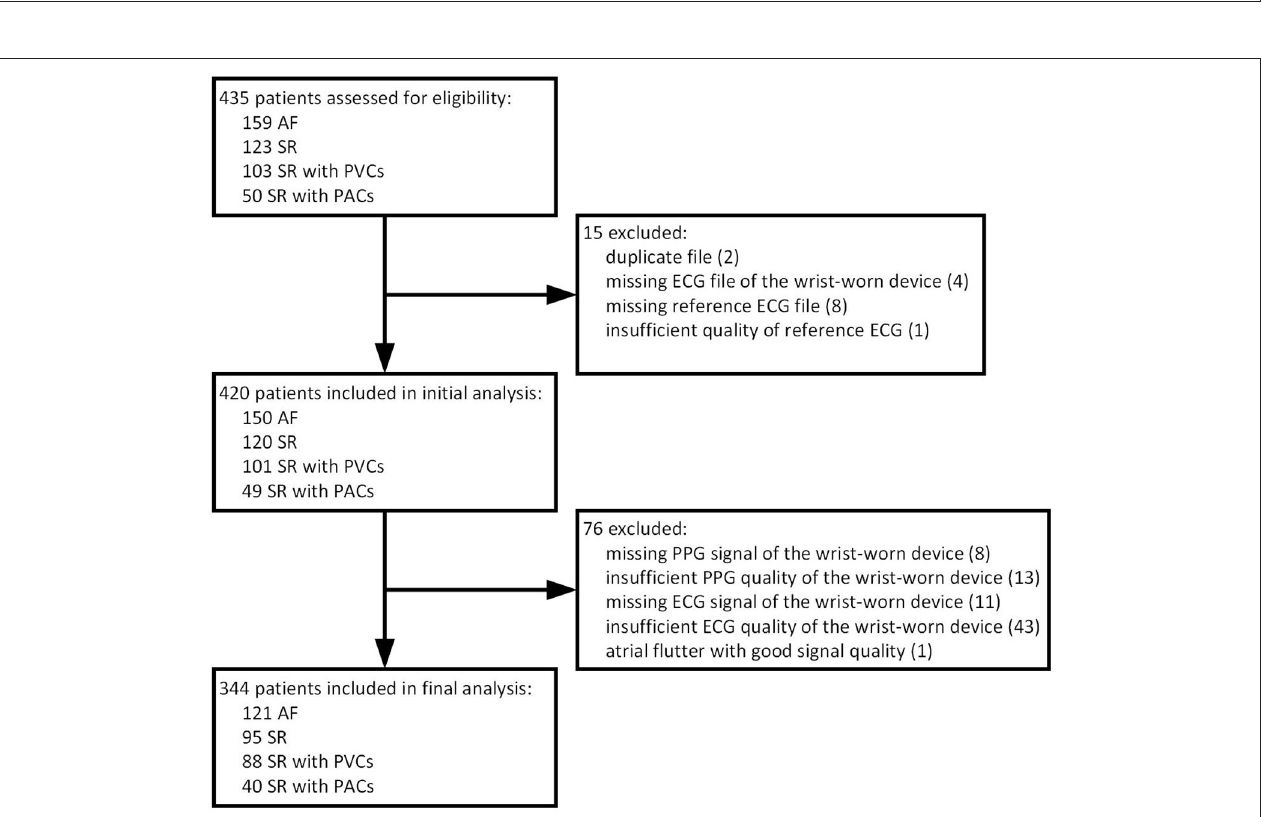
Frontiers in Cardiovascular Medicine |